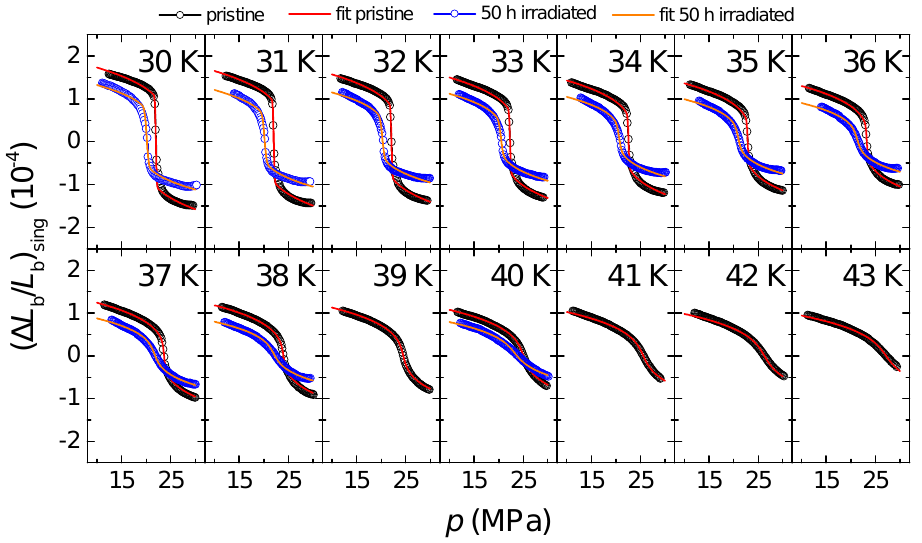
Figure 4. Singular part of the relative length change of κ -(BEDT-TTF) 2 Cu[N(CN) 2 ]Cl along the out-of-plane b axis, ( ∆ L b / L b ) sing , (open symbols) as a function of pressure p at various temperatures 30K ≤ T ≤ 43K, together with a fit (straight lines) based on the mean-field solution, given by Equation (1). Black open symbols and red straight lines represent results on a pristine sample of batch #AF063, which were published in Ref.[25]. Blue open symbols and orange lines represent results on a crystal of batch #AF063 which was exposed to X-ray for